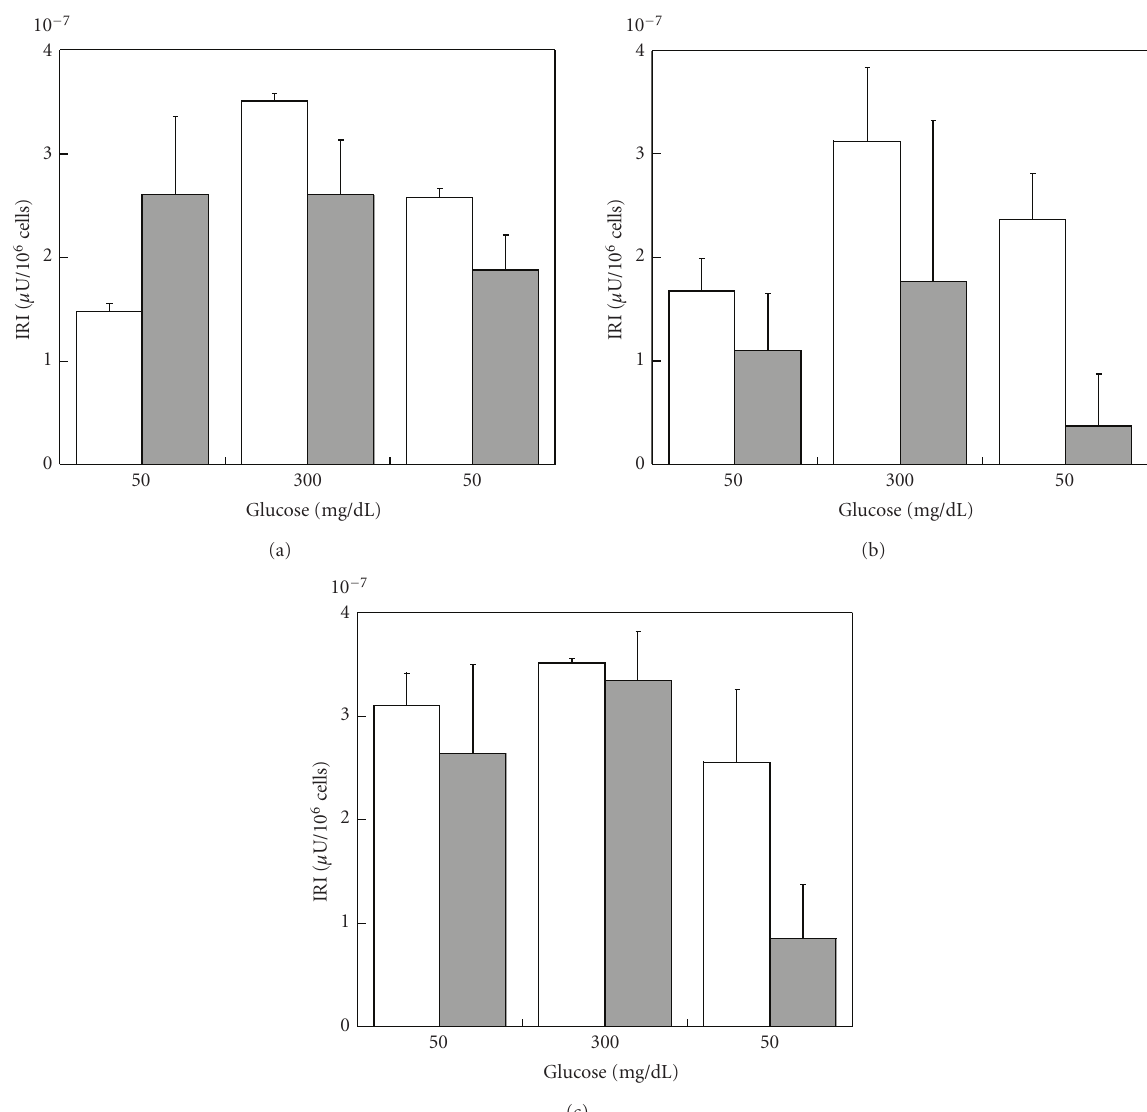
Figure 2: Ratio insulin/total cell number of control NPI cell monolayers alone (open bars), or NPI cell monolayers cocultivated with microencapsulated SC (gray bars) for 7 (a), 14 (b), and 21 days (c). Data are shown as means ± SD from 3